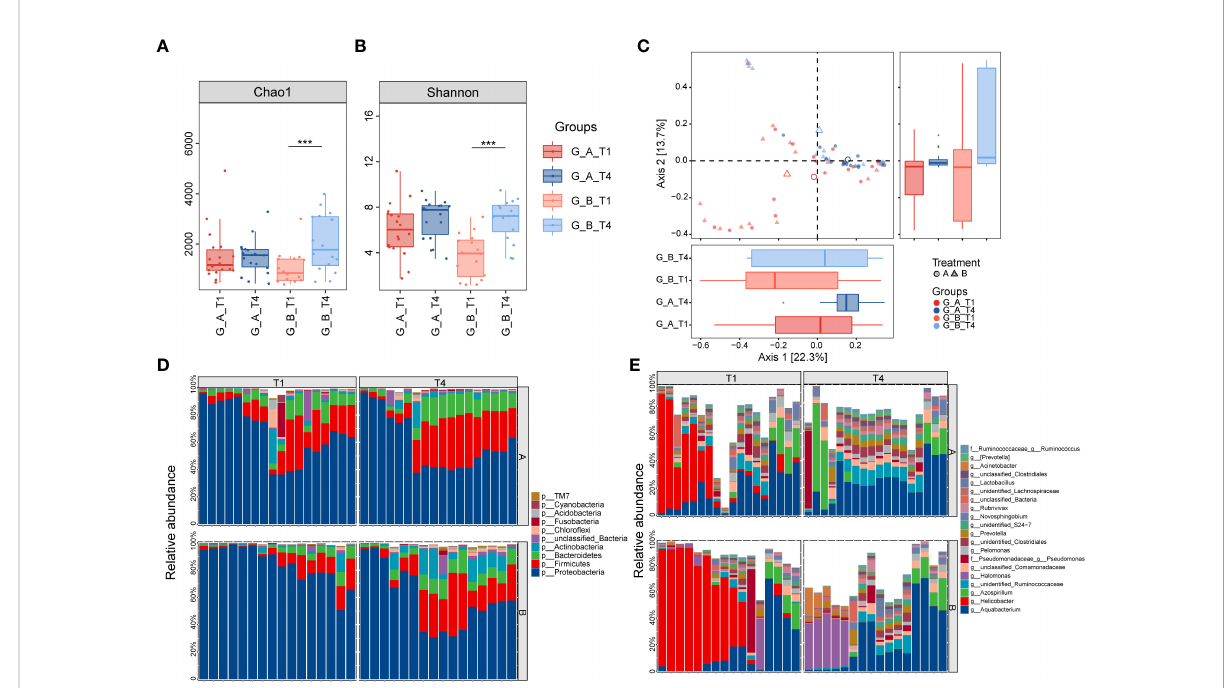
FIGURE 5 Longitudinal changes of gastric microbial diversity and composition after H. pylori eradication. (A, B) Box and whisker plots of the alpha diversity indices for richness and diversity of the bacterial communities on the ASV level in patients treated with either probiotics or placebo at T1 and T4, respectively. (C) Beta diversity analysis is represented by principal coordinate analysis based on Bray-Curtis distance. The red samples (T1) are deviated from the blue samples (T4). Relative abundance of the top 10 phyla (D) and the top 20 genera (E) in gastric mucosa. ***, p<0.001. A, probiotics group; B, placebo group; T1, pretreatment; T4, 8 weeks after quadruple therapy; T1, pretreatment; T4, 8 weeks after quadruple